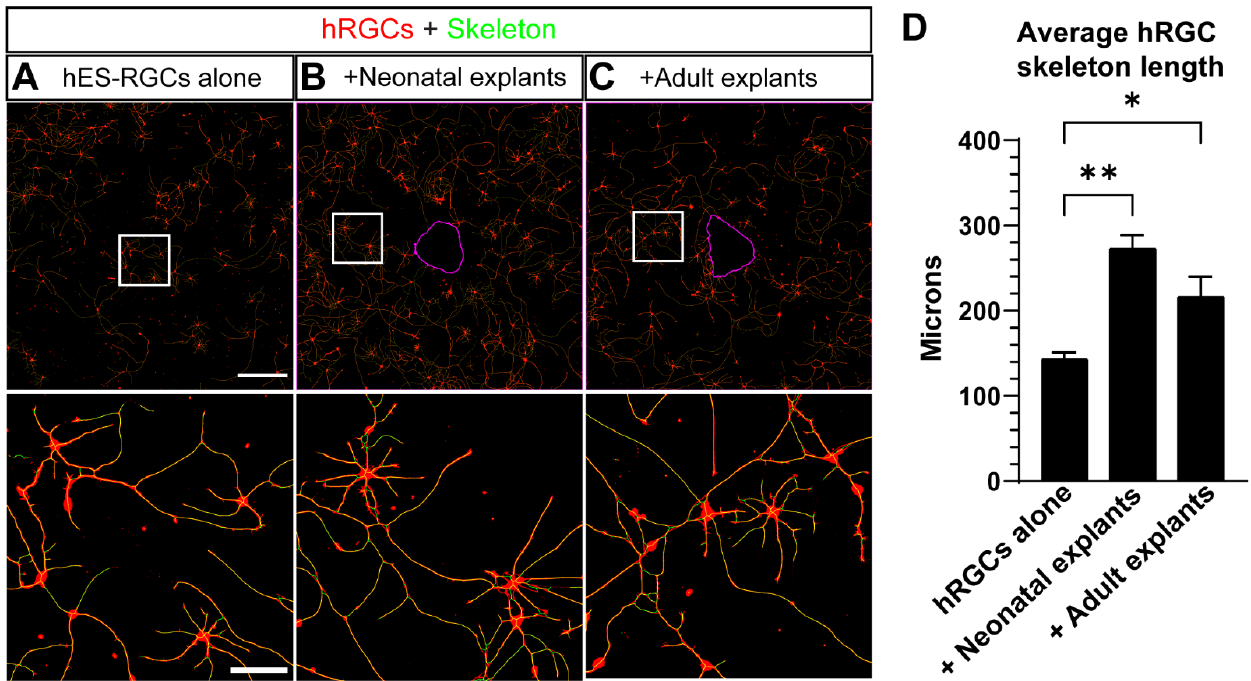
Figure 2. Mouse retina explants increase hRGC neurite outgrowth. ( A – C ) Representative images of 6 DIV hRGCs overlayed with their generated skeletons, cultured alone ( A ), with neonatal explants ( B ), and adult explants ( C ). A magenta outline of the explant perimeter is depicted in ( B ) and ( C ) Bottom panels represent magnified views of the square boxes in top panels. ( D ) The average hRGC skeleton length was quantified by dividing the total length of hRGC skeletons by the number of DAPI+ cells. The presence of both neonatal ( p = 0.0015) and adult ( p = 0.0475) increases the average length of hRGC skeletons. hRGCs alone: N = 4 coverslips, n = 4 2.9 × 2.9 mm images, +Neonatal explants: N = 6, n = 3 – 5, +Adult explants: N = 7, n = 3 –5. Scale bars: A top = 500 μm, A bottom = 100